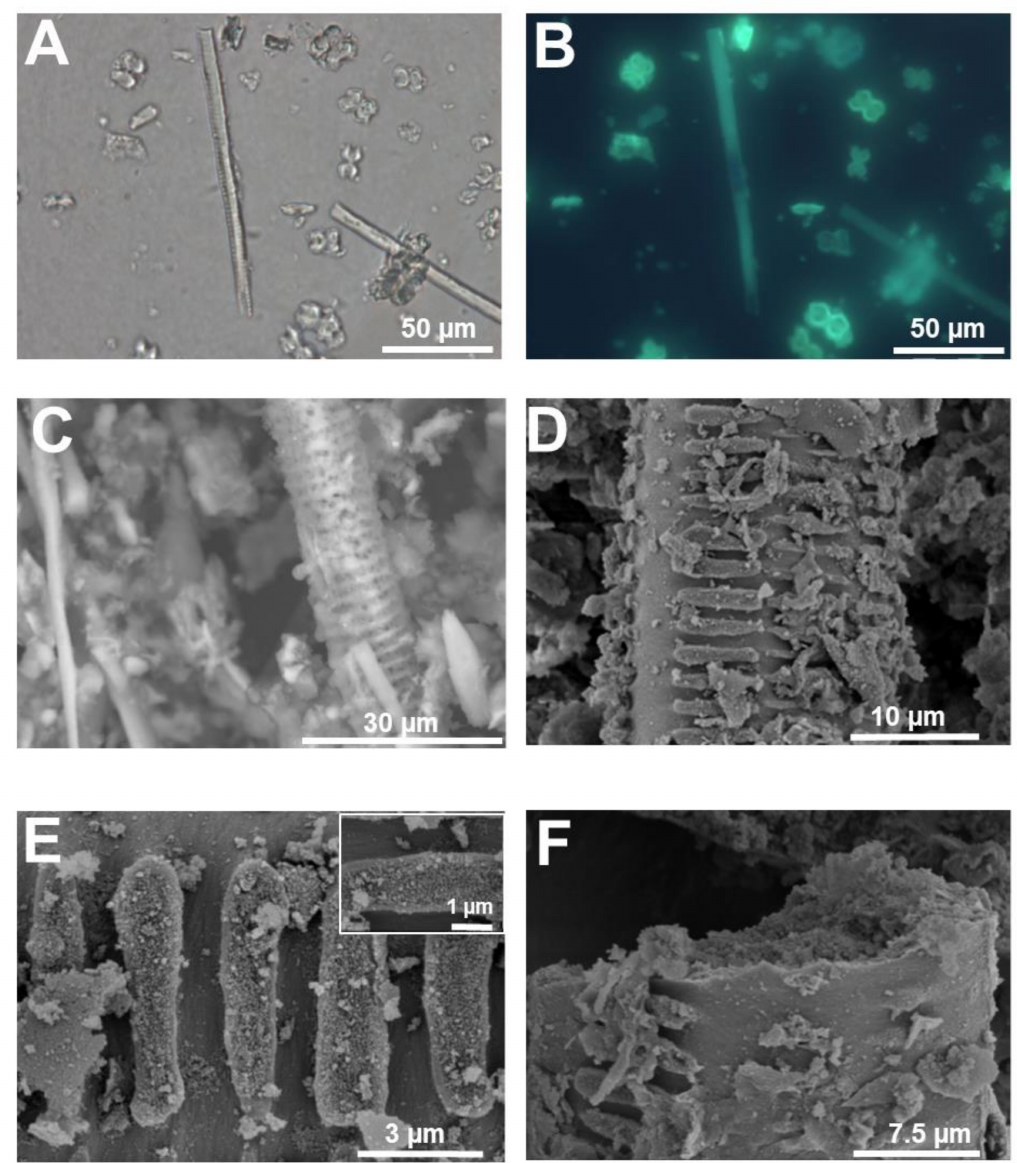
Figure6. Silicifiedxylemvesselfromricestem. ( A )Di ff erentialinterferencecontrastand( B )fluorescence microscopy after PDMPO staining of silica extracted from rice stem. A xylem vessel is present among silica cells. ( C ) SEM image (topographic contrast) of a rice silicified xylem vessel. ( D ) Details of helical cell wall thickenings. ( E ) Helical thickening of the silicified xylem vessel in ( D ). Inset: fine details of the granular material present on the surface of the thickenings in ( D ). ( F ) Detail of the granular material forming the silicified cell walls of the xylem vessel in ( D ). Images ( D – F ) were taken using a Hitachi S-4500 SEM. Images ( A , B ) were taken using an Olympus BX50 fluorescence microscope and image ( C ) with a HITACHI TM3000 TableTop